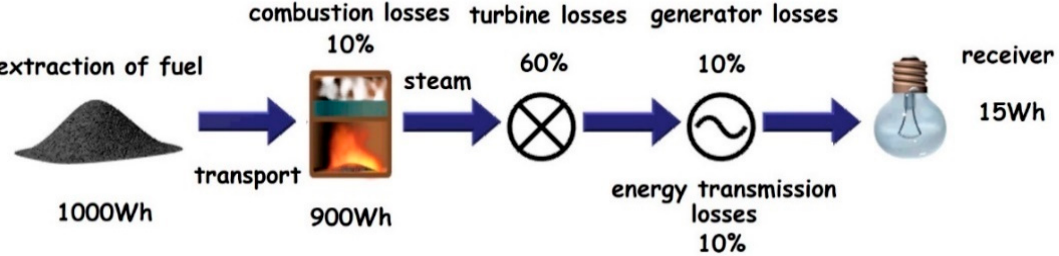
Figure 1. An example of a conventional energy system.